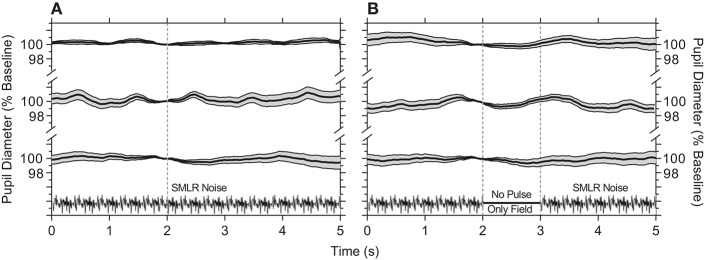
Pupil responses to temporal white noise. (A) Temporal white noise is presented for 5,000 ms then repeated; pupil diameter is steady during continuous presentation of the temporal white noise. (B) A 1,000 ms blank equal to the time average chromaticity and retinal illuminance of the orange field (no pulse, only field) is inserted within the temporal white noise; this blank field does not cause a pupil constriction. Panels show the average ±95% confidence limits for each of three observers (traces vertically offset; ~100 trials per observer). Pupil responses are normalized to the diameter at 2 s (vertical line) during each 5,000 ms repeat.